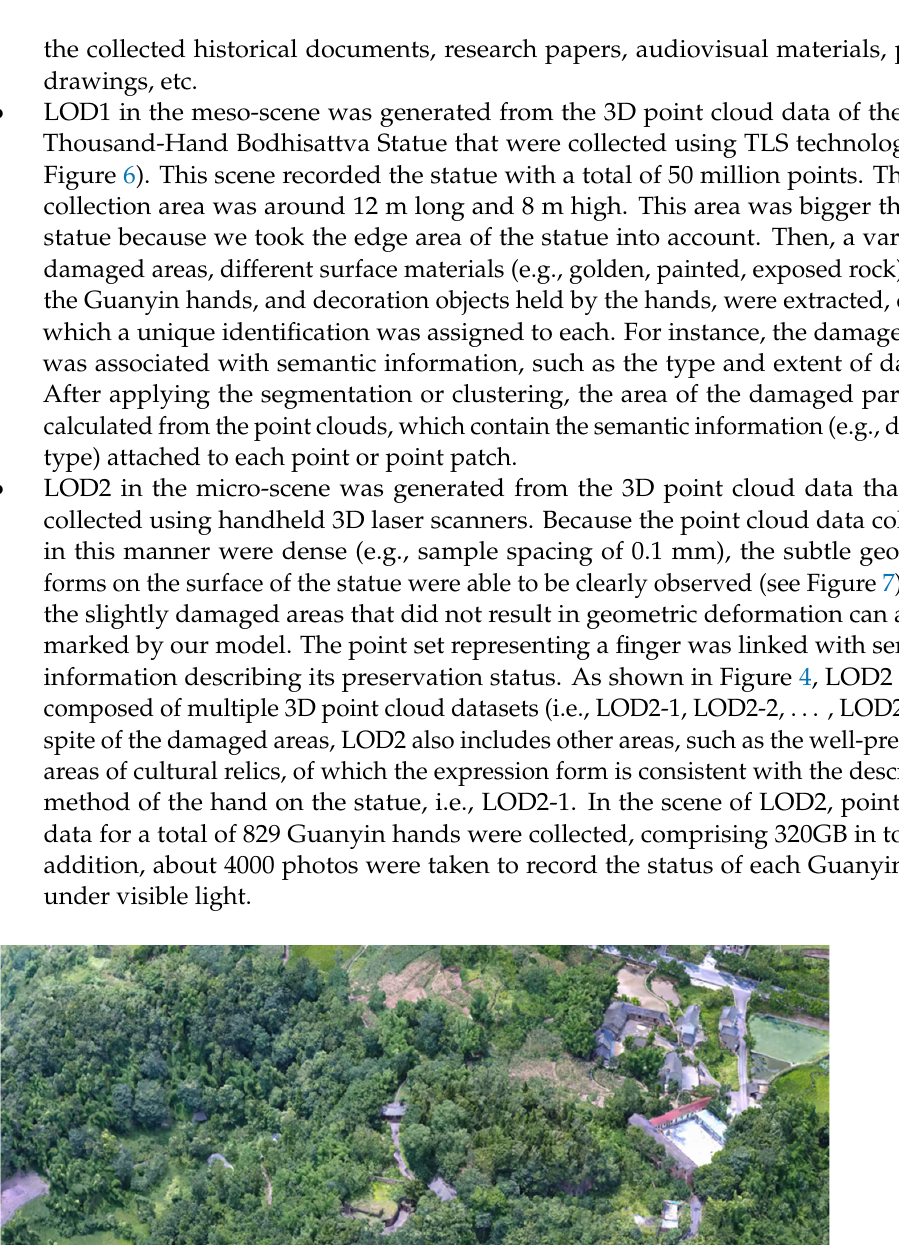
( d ) Figure 6. ( a ) LOD1—the meso-scene, comprising 3D point cloud data of the Dazu Thousand-Hand Bodhisattva Statue in 2011; ( b ) partial capture of point cloud data in 2011; ( c ) LOD1—3D point cloud